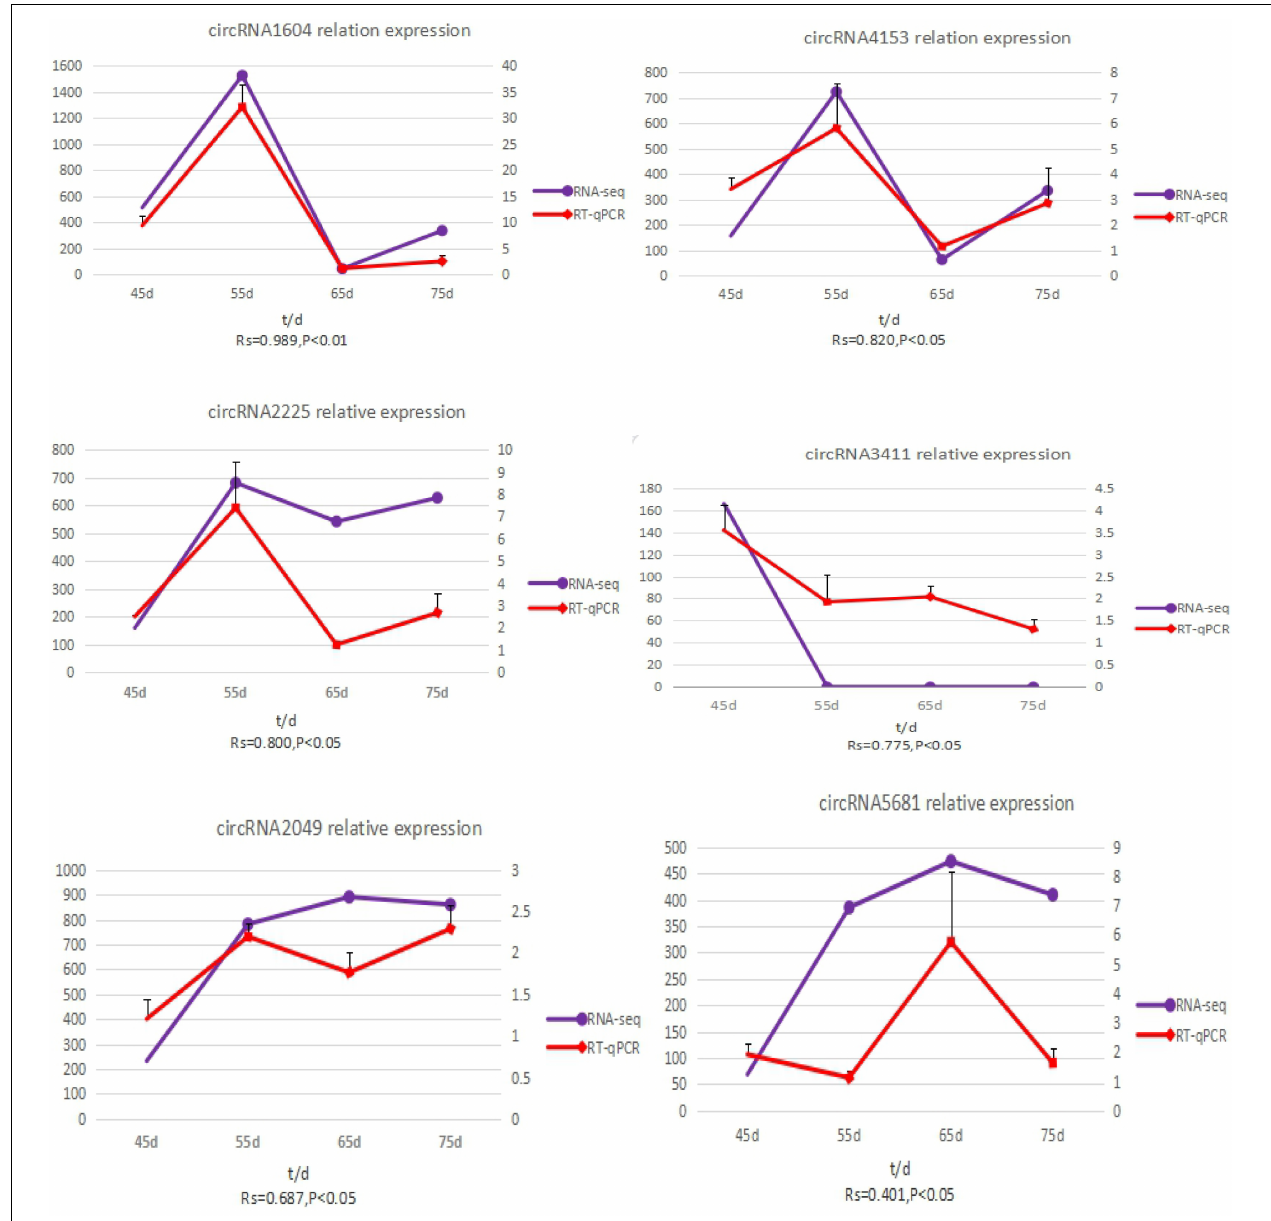
FIGURE 5 | The expression quantity and expression trend of circRNA in different periods. A total of 0.8 < | Rs| < 1 indicates a strong correlation; 0.6 < | Rs| < 0.8 indicates a strong correlation; 0.4 < | Rs| < 0.6 indicates a moderate correlation; 0.2 < | Rs| < 0.4 indicates a weak correlation; 0 < | Rs| < 0.2 indicates no correlation; and the degree of proximity between | Rs| and 1 represents the degree of closeness and correlation between two variables.